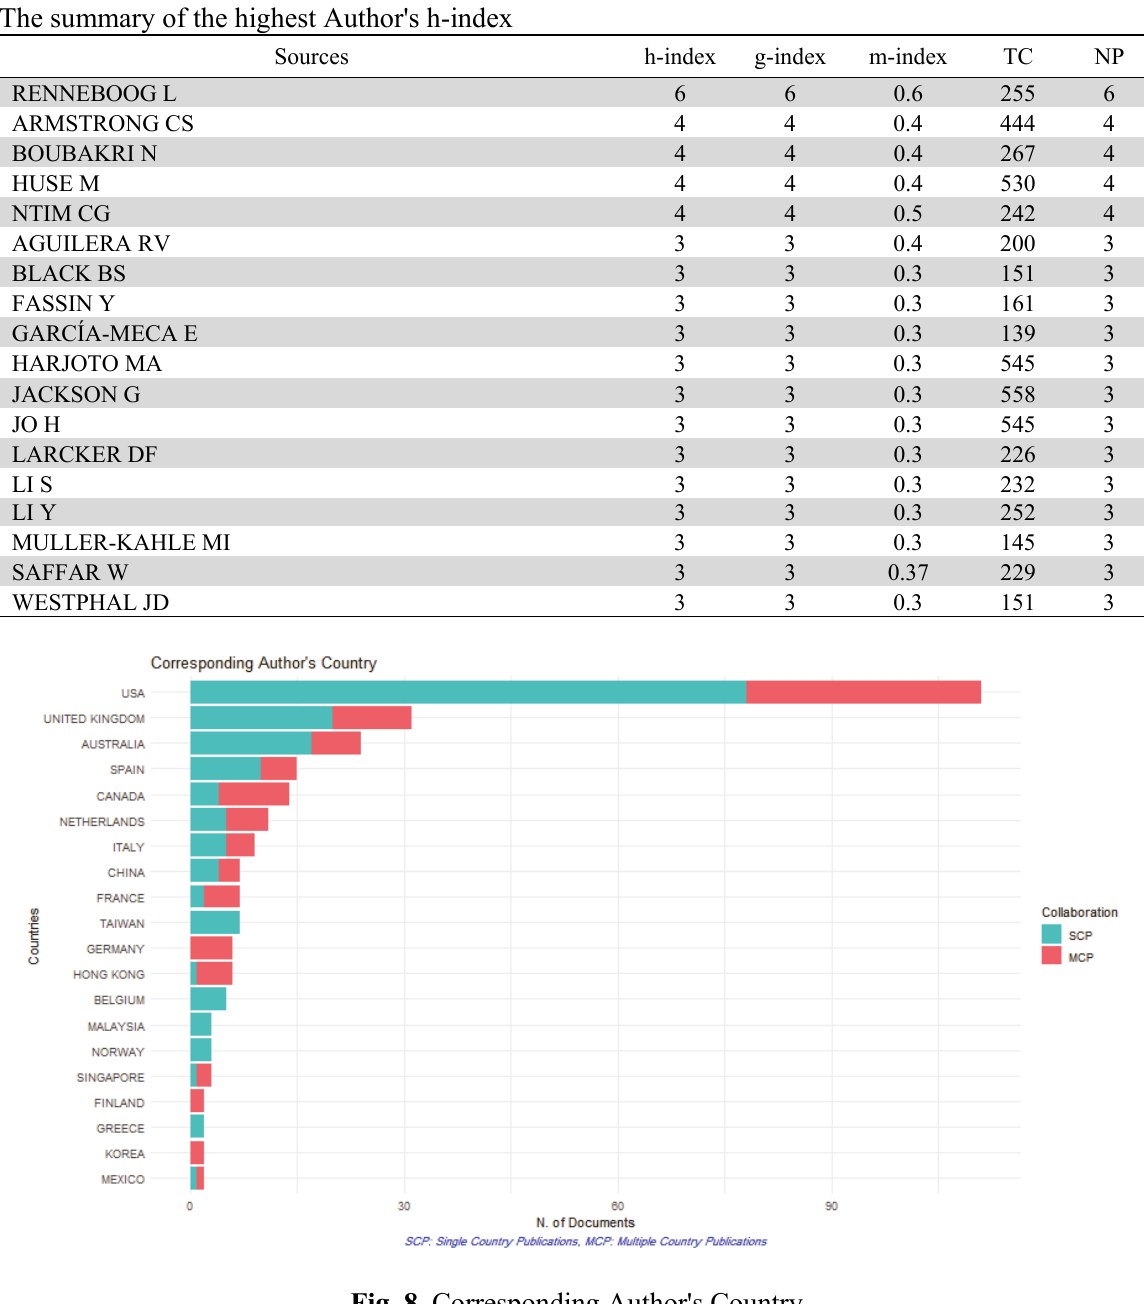
Fig. 8. Corresponding Author's